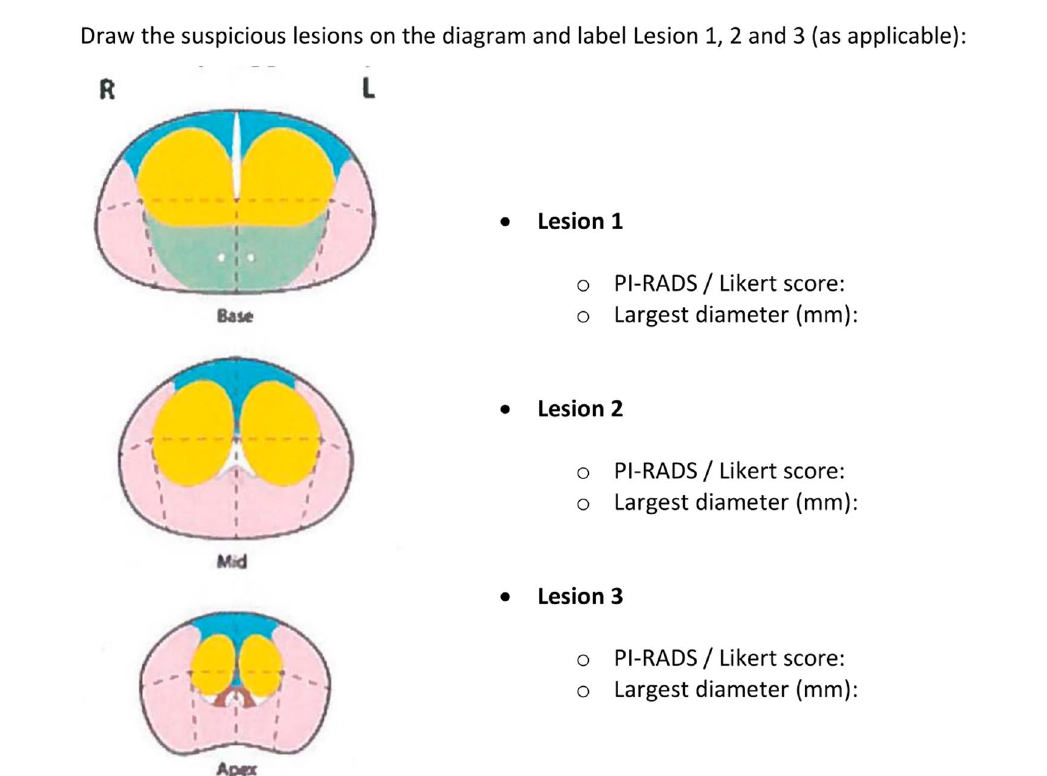
Fig. 3 Scoring sheet for baseline scans